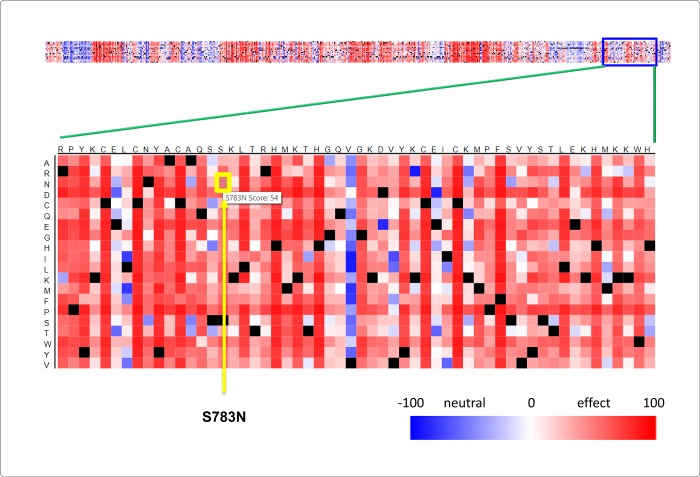
Heatmap of BCL11A protein.The yellow box indicates the most pathogenic amino acid change (S783N) in the BCL11A gene, corresponding to rs61742690.